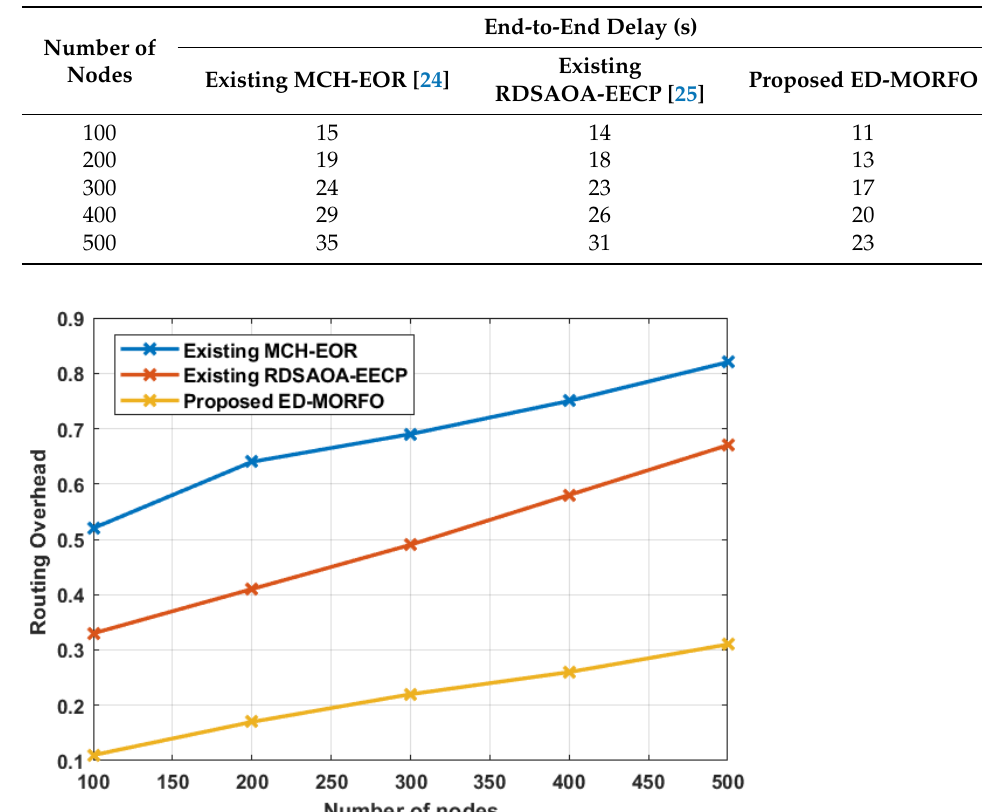
Figure 7. Performance of end-to-end delay for proposed EDMORFO and Existing MCH-EOR [24], RDSAOA-EECP [25]. Table 6. Performances of end-to-end delay.